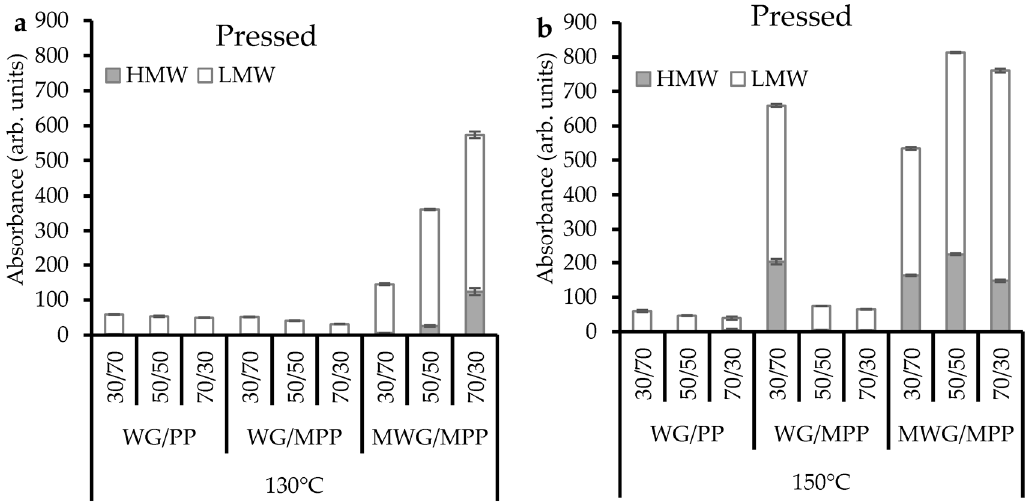
Figure 2. Total protein extractability of WG/PP, WG/MPP and MWG/MPP samples pressed at 130 °C ( a ) and 150 °C ( b ), as studied by SE-HPLC.